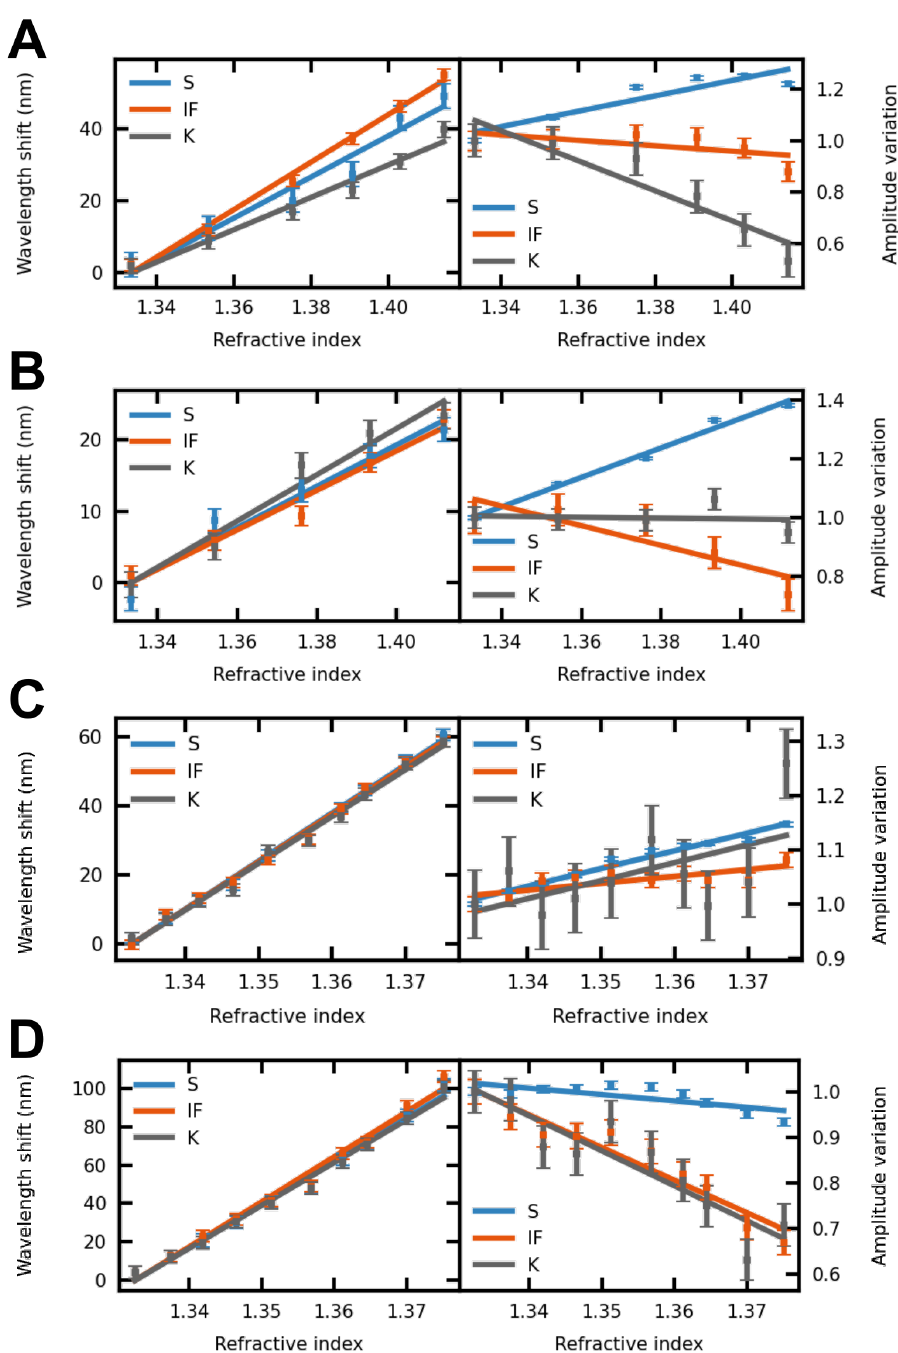
Figure A6. Refractive index sensitivity for the plasmonic optical fiber sensor using the three methods (S, IF, and K) in terms of both wavelength and amplitude shift tracking. Optical fiber coated with ( A ) gold nanoparticles; ( B ) silver nanoparticles; ( C ) gold thin film; ( D ) silver thin film. RIS explicit for the gold and silver nanoparticles/thin